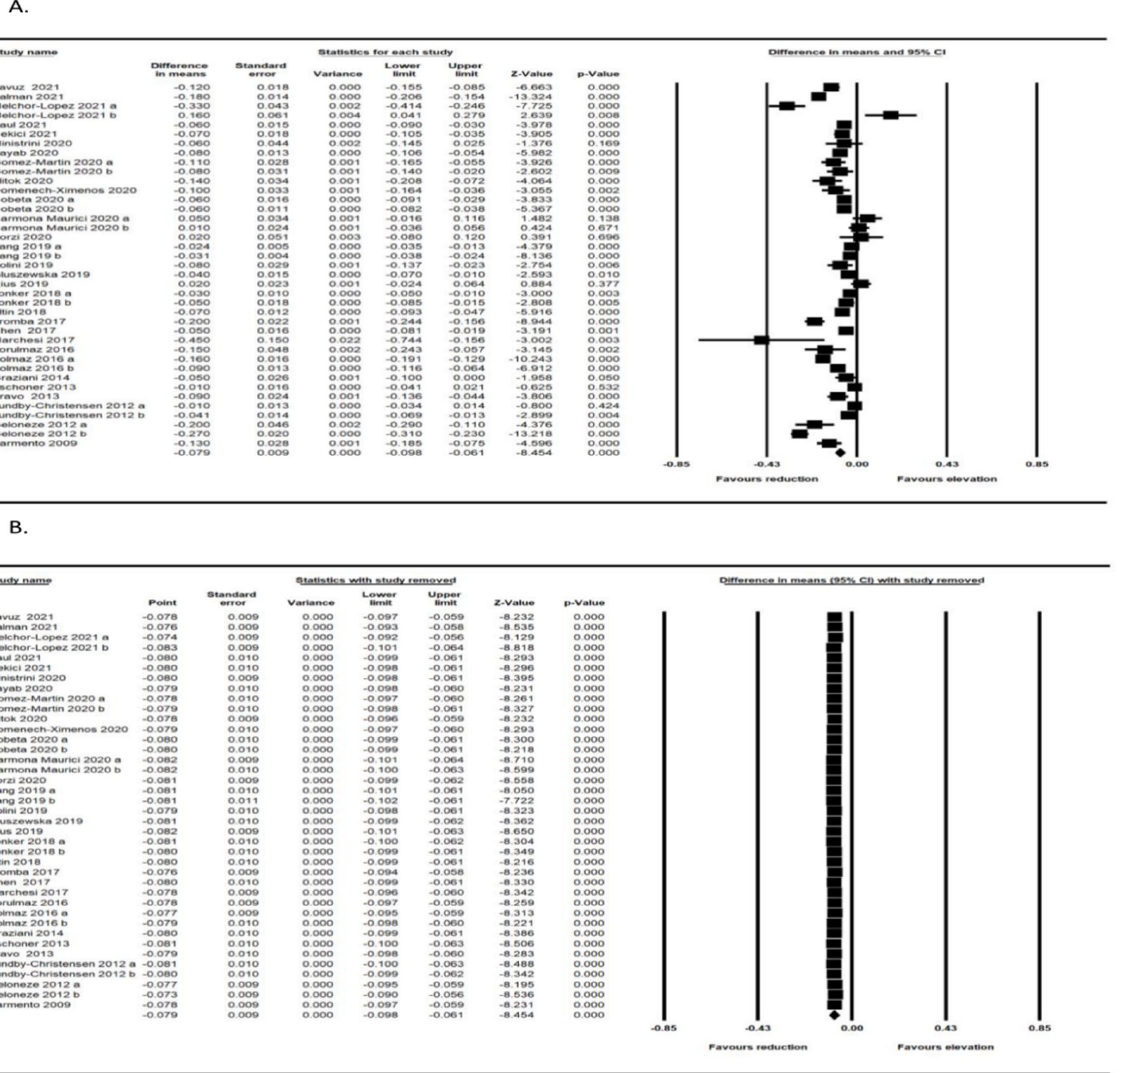
Figure 2. ( A ) Forest plot displaying standardized mean difference and 95% confidence intervals showing the consequence of bariatric surgery on IMT [16,32–60]; ( B ) Leave ‐ one ‐ out sensitivity analyses indicating the effect of bariatric surgery on IMT [16,32–60].